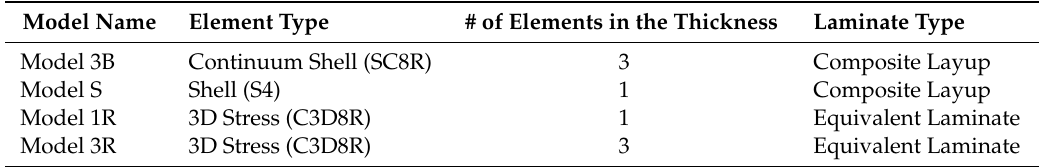
Table 5. Investigated element formulations.